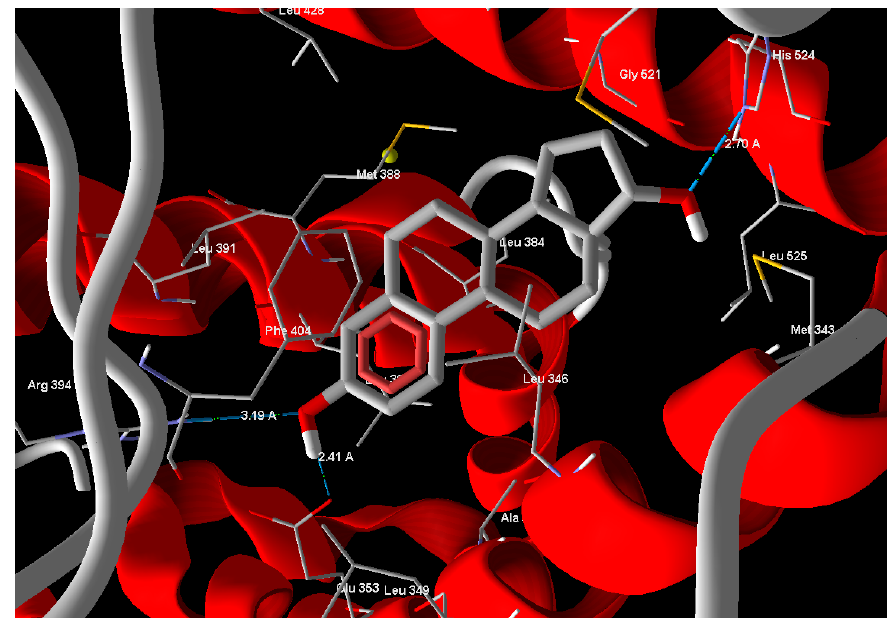
Figure 3. Estrogen showed hydrogen bonds interactions with ER α -LBD active site.